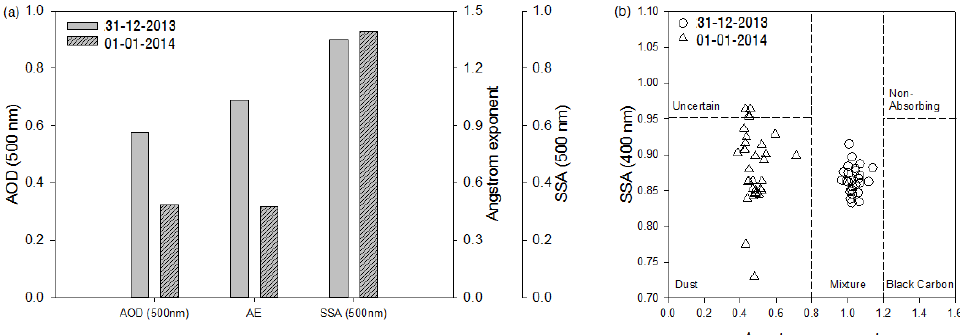
Figure 3. ( a ) Aerosol optical depth (500 nm), Ångström Exponent, and Single Scattering Albedo (500 nm) and ( b ) the frequency distribution of aerosol types from 31 December 2013 and 1 January 2014.